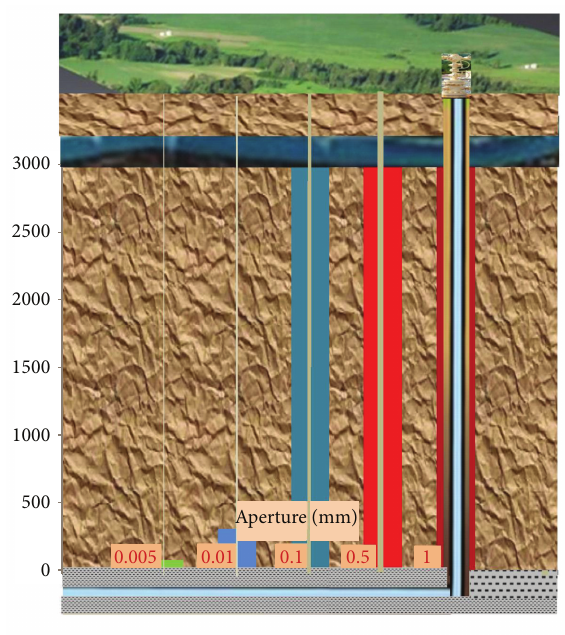
Figure15:Verticalparallelmodelplatemodelfordifferentapertures for a period of 14 years.